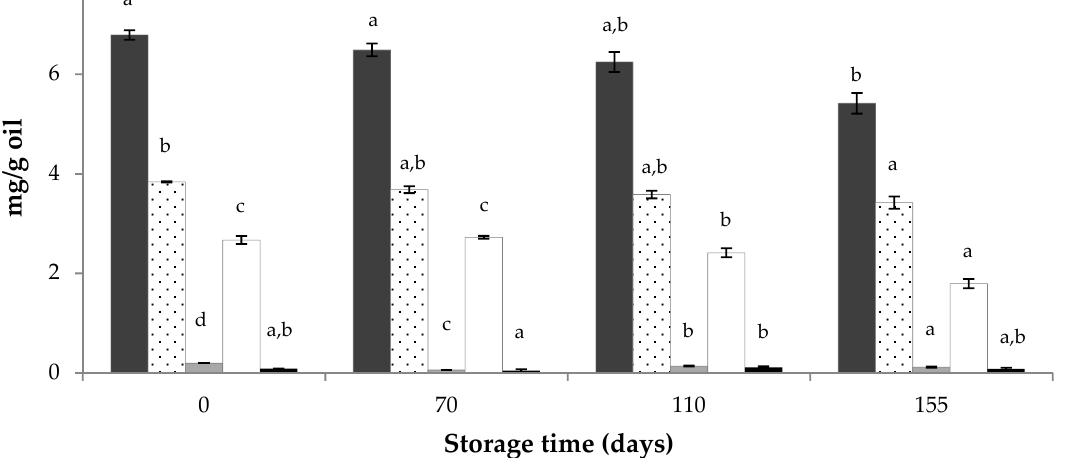
Figure 1. Variation of alkylresorcinol (AR) contents during storage at 21 ± 1 °C and darkness of the SCWBOE. Different letters within the same compound indicate significant mean differences according to LSD test at p < 0.05.